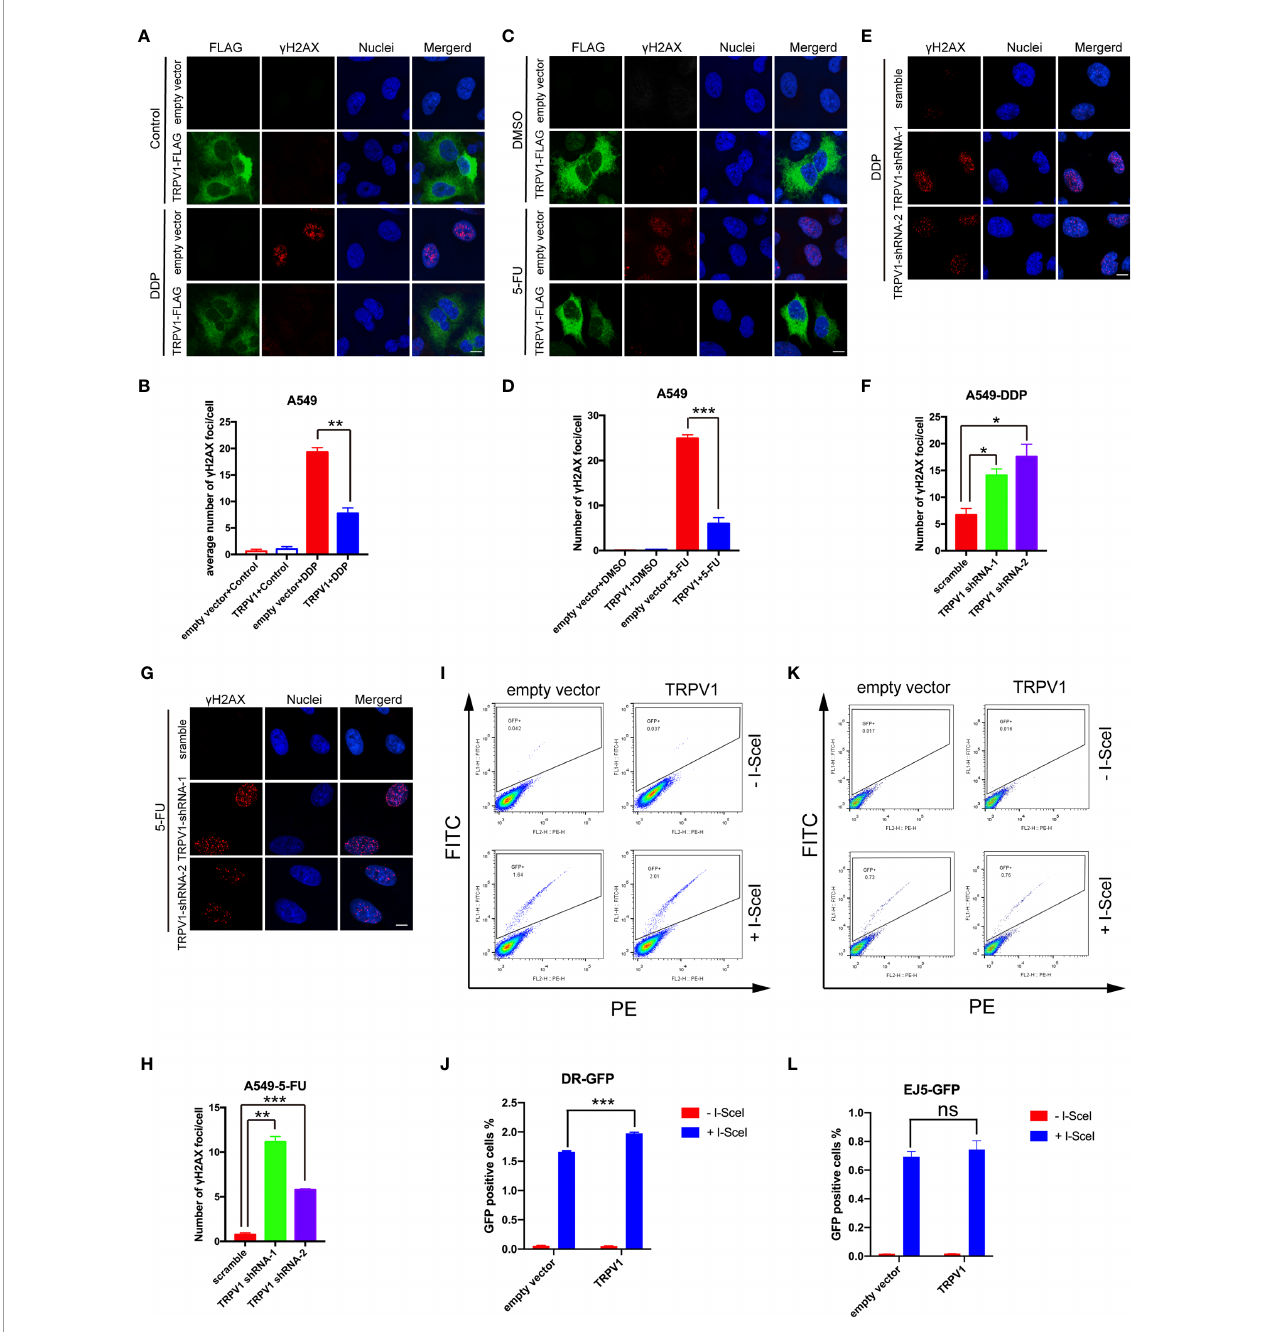
FIGURE 6 | TRPV1 overexpression increased DNA repair via the HR pathway. (A) TRPV1 overexpression decreased the number of g H2AX foci induced in A549 cells by DDP treatment (1 m M) for 24 h. Scale bar, 10 m m. (B) Statistical analysis of A. At least 100 transfected cells were analyzed. (C) TRPV1 overexpression decreased the number of g H2AX foci induced in A549 cells by 5-FU treatment (0.5 m g/mL) for 24 h. Scale bar, 10 m m. (D) Statistical analysis of C. At least 100 transfected cells were analyzed. (E) TRPV1 knockdown increased the number of g H2AX foci induced in A549-DDP resistant cells by DDP treatment (4 m M) for 24 h. Scale bar, 10 m m. (F) Statistical analysis of E. At least 100 cells were analyzed. (G) TRPV1 knockdown increased the number of g H2AX foci induced in A549-5-FU resistant cells by 5-FU treatment (3.5 m g/mL) for 24 h. Scale bar, 10 m m. (H) Statistical analysis of (G) . At least 100 cells were analyzed. (I) Flow cytometric DR-GFP reporter assay showing that TRPV1 overexpression increased HR DNA repair ef fi cacy. (J) Statistical analysis of I. (K) Flow cytometric EJ5-GFP reported assay showing that TRPV1 overexpression had no effect on NHEJ DNA repair ef fi cacy. (L) Statistical analysis of (K) . Three independent experiments were performed. Statistical signi fi cance was determined using Student ’ s t test. Data represent mean ± SEM; * P < 0.05. ** P < 0.01. *** P < 0.001. ns, not statistically signi fi